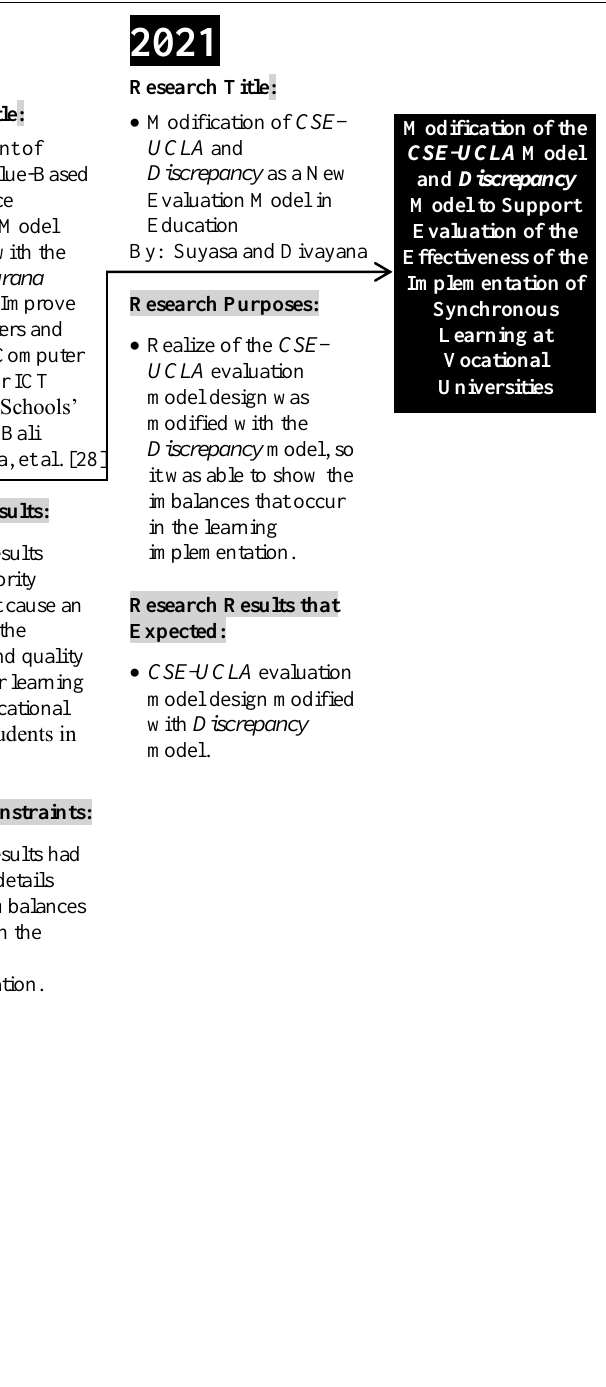
Figure 1. Research